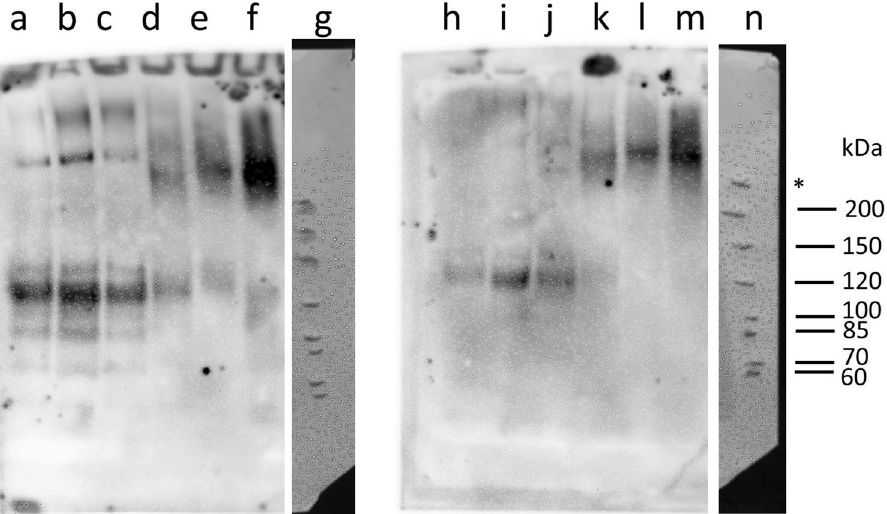
Figure 3. Total and mutant HTT in blood and saliva from premanifest HD individuals. Fifteen micrograms of blood ( a – c , h – j ) and saliva ( d – f , k – m ) were probed with antibodies for total HTT (1:500 4E10; lanes a – f ) and mutant HTT (1:500 MW1; lanes h – m ) on two NuPAGE 3–8% Tris–Acetate Protein Gels, run simultaneously in the same electrophoresis and transfer system. Blood and saliva samples were matched (participant 1: a , d , h , k ; participant 2: b , e , i , l ; participant 3: c , f , j , m ). Lane g and m show white-light images of pencil markings of the PageRuler™ Unstained Protein Ladder, marked after Ponceau S membrane staining; *indicates a high